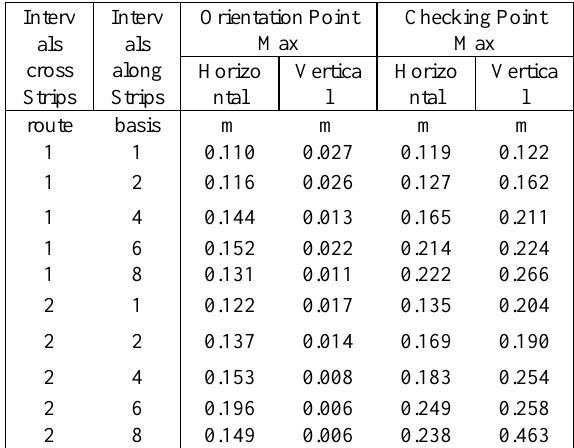
Table 4. Accuracy of area 2 by GeoLord-AT software